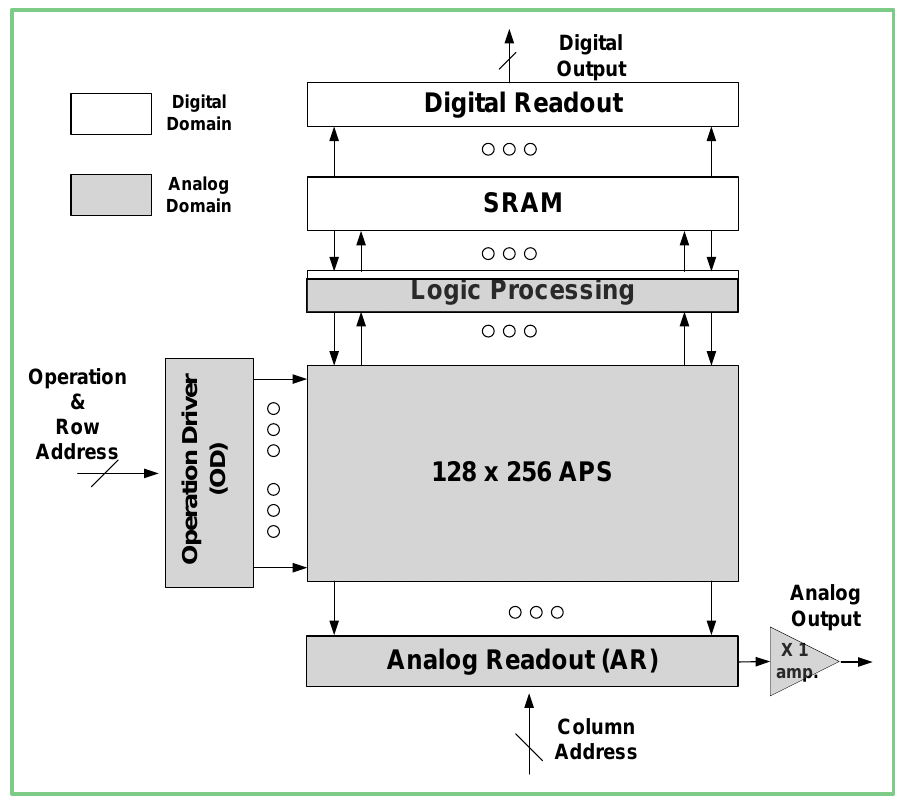
Figure 1. Block diagram of the